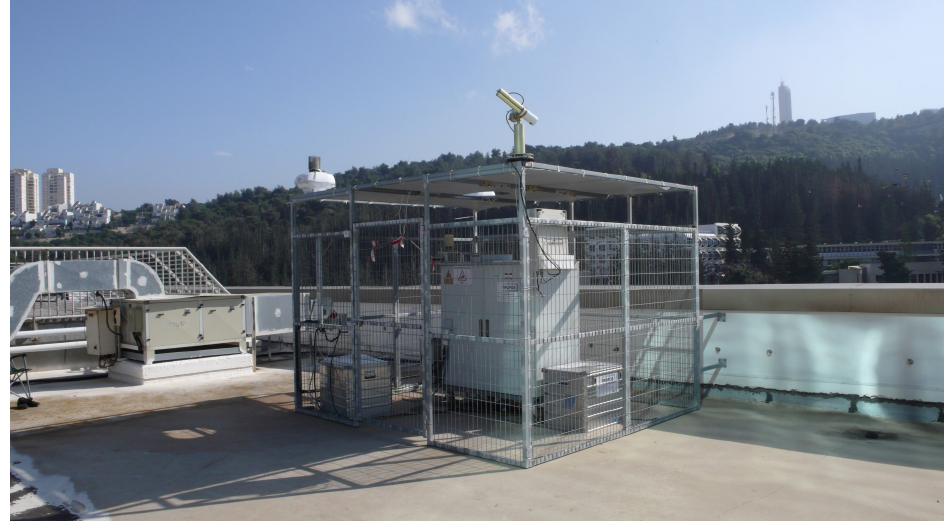
Figure 1. Polly XT on the rooftop platform at Technion, Haifa, in March 2017. The instrument is placed inside a protective cage to avoid unauthorized access. On top of the cage, an air-safety radar is monitoring the sky for airplanes, and an AERONET sun photometer is measuring the aerosol optical thickness. In the background, the northern tips of the Carmel mountain range and the tower of the University of Haifa can be seen.